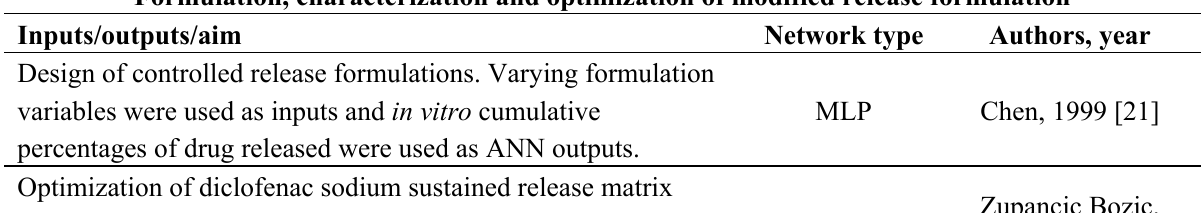
Table 3. Formulation, characterization and optimization of modified release solid dosage forms are listed, with respect to inputs/outputs selected, type of the network used, and the authors(year) of performed